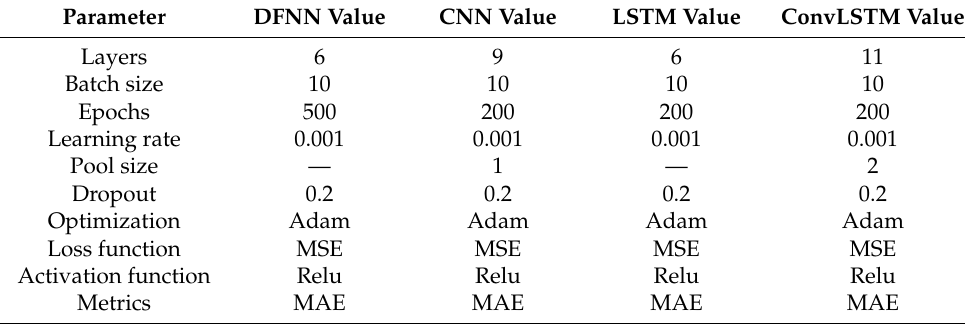
Table 5. Four deep learning model parameter settings.